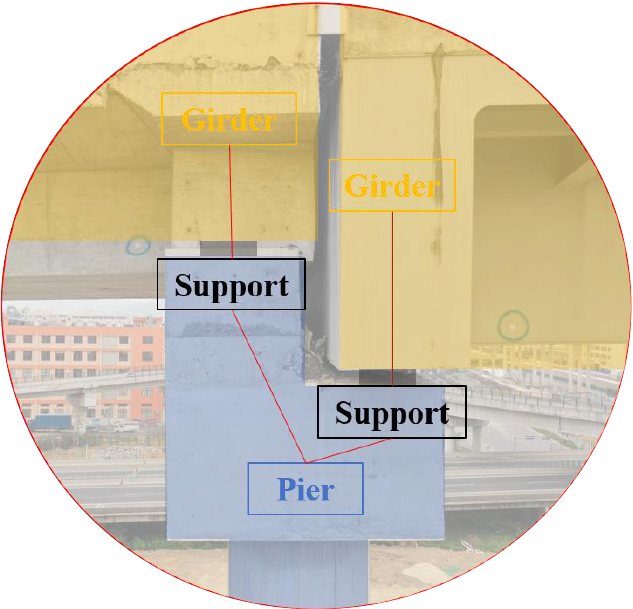
Figure 4. Critical pier – support – girder region.